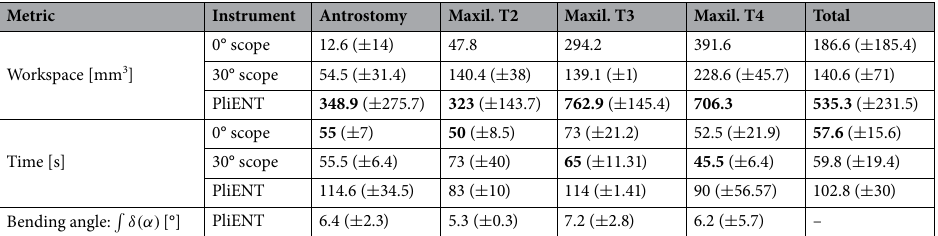
Table 2. Mean and standard deviation of the time taken for inspection of all the walls of one maxillary sinus, the workspace corresponding to the volume of the alpha shape calculated from the position data of the EM sensor placed at the instrument’s tip and bending angle of the PliENT endoscope. Each metric was measured/ calculated for each instrument and for each considered enlargement procedure. The shortest time and the largest workspace is indicated in bold for each enlargement procedure. The last column (marked Total ) lists mean and standard deviation of all the tests realized with a specific instrument, accumulated over all the enlargement